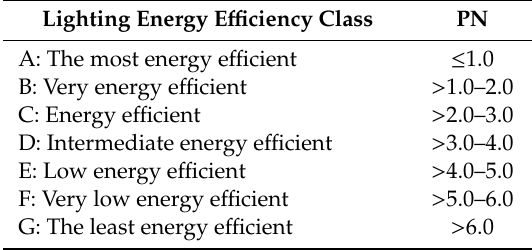
Table 9. The energy efficiency classification proposal for interior lighting based on the normalized power density PN [W/m 2 per 100 lx].